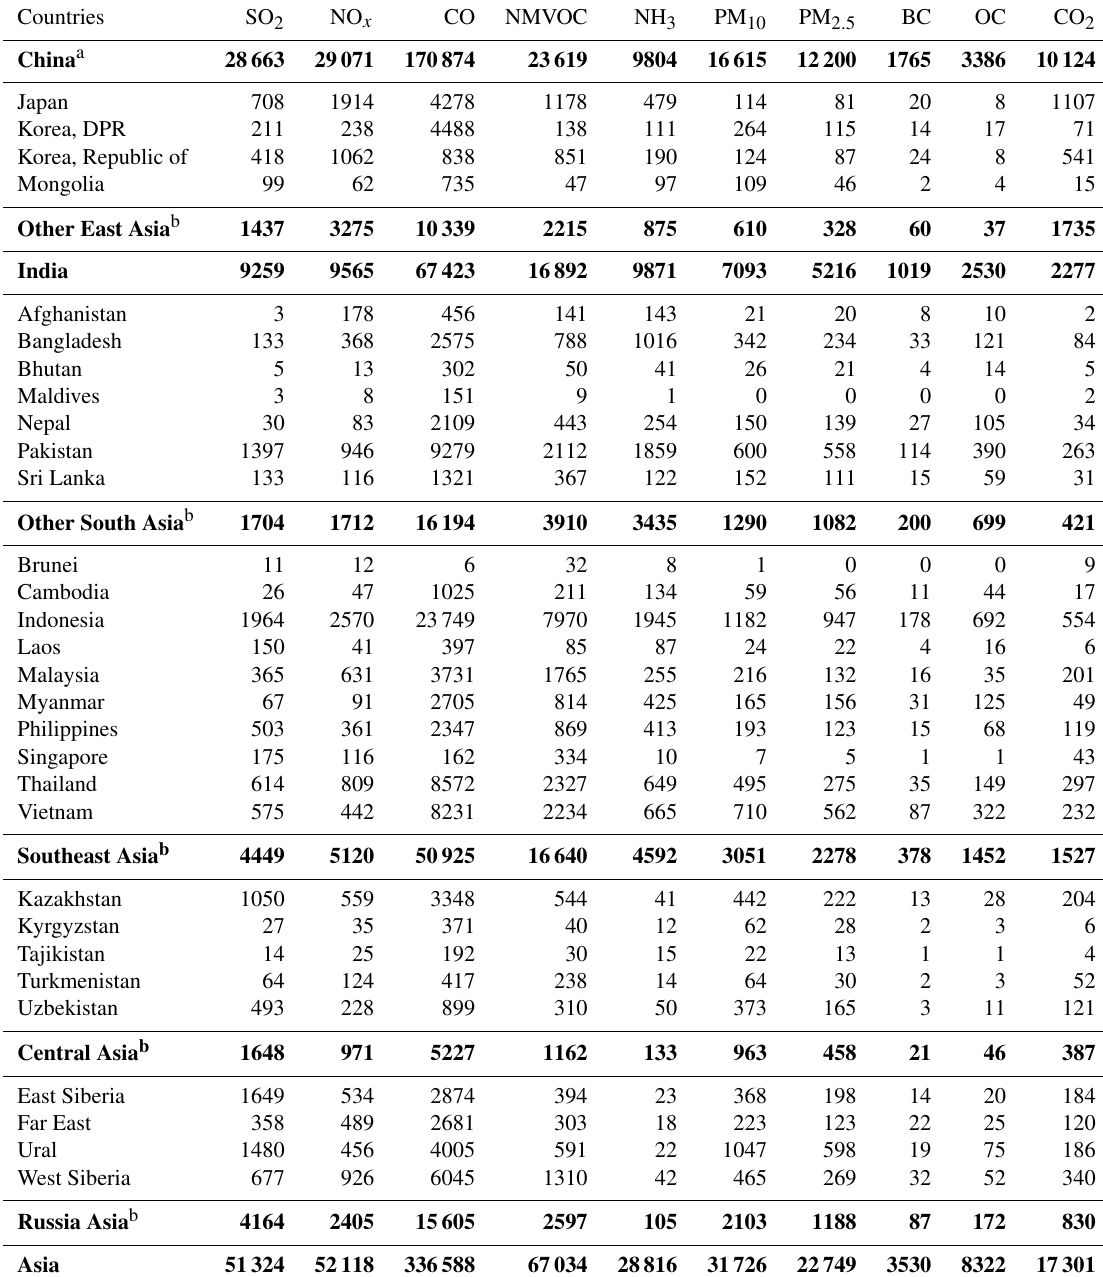
Table 3. National anthropogenic emissions in the MIX emission inventory in 2010 (units: Tg for CO 2 and Gg for other species). Bold values are the total emissions for Asian